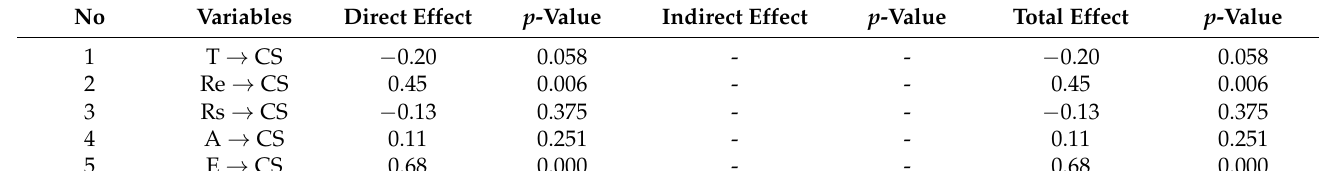
Table 2. Relationship Between the Five Factors.